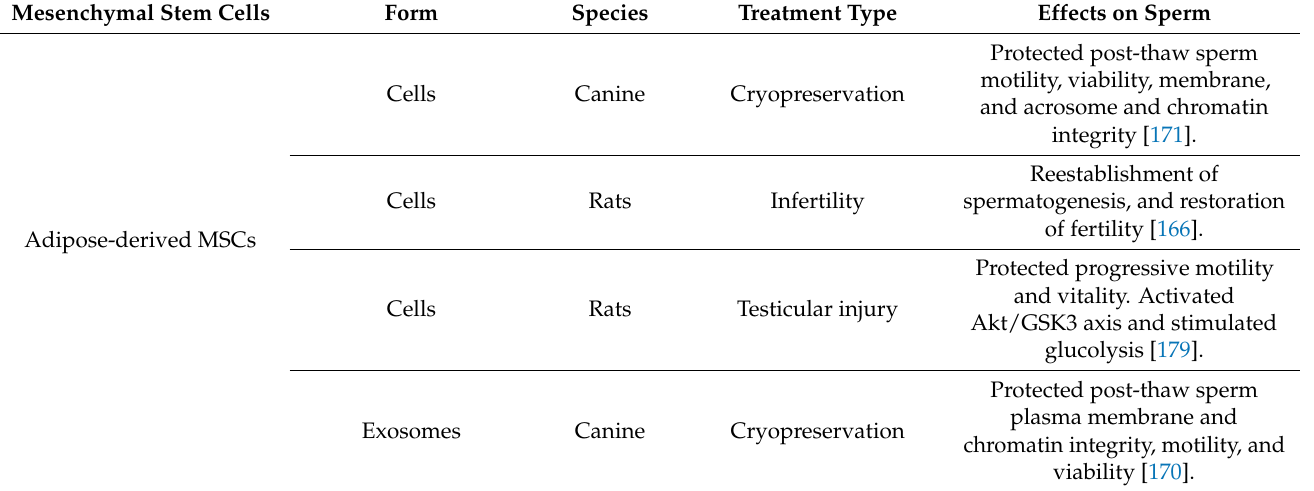
Table 2. Use of mesenchymal stem cells in male reproduction and